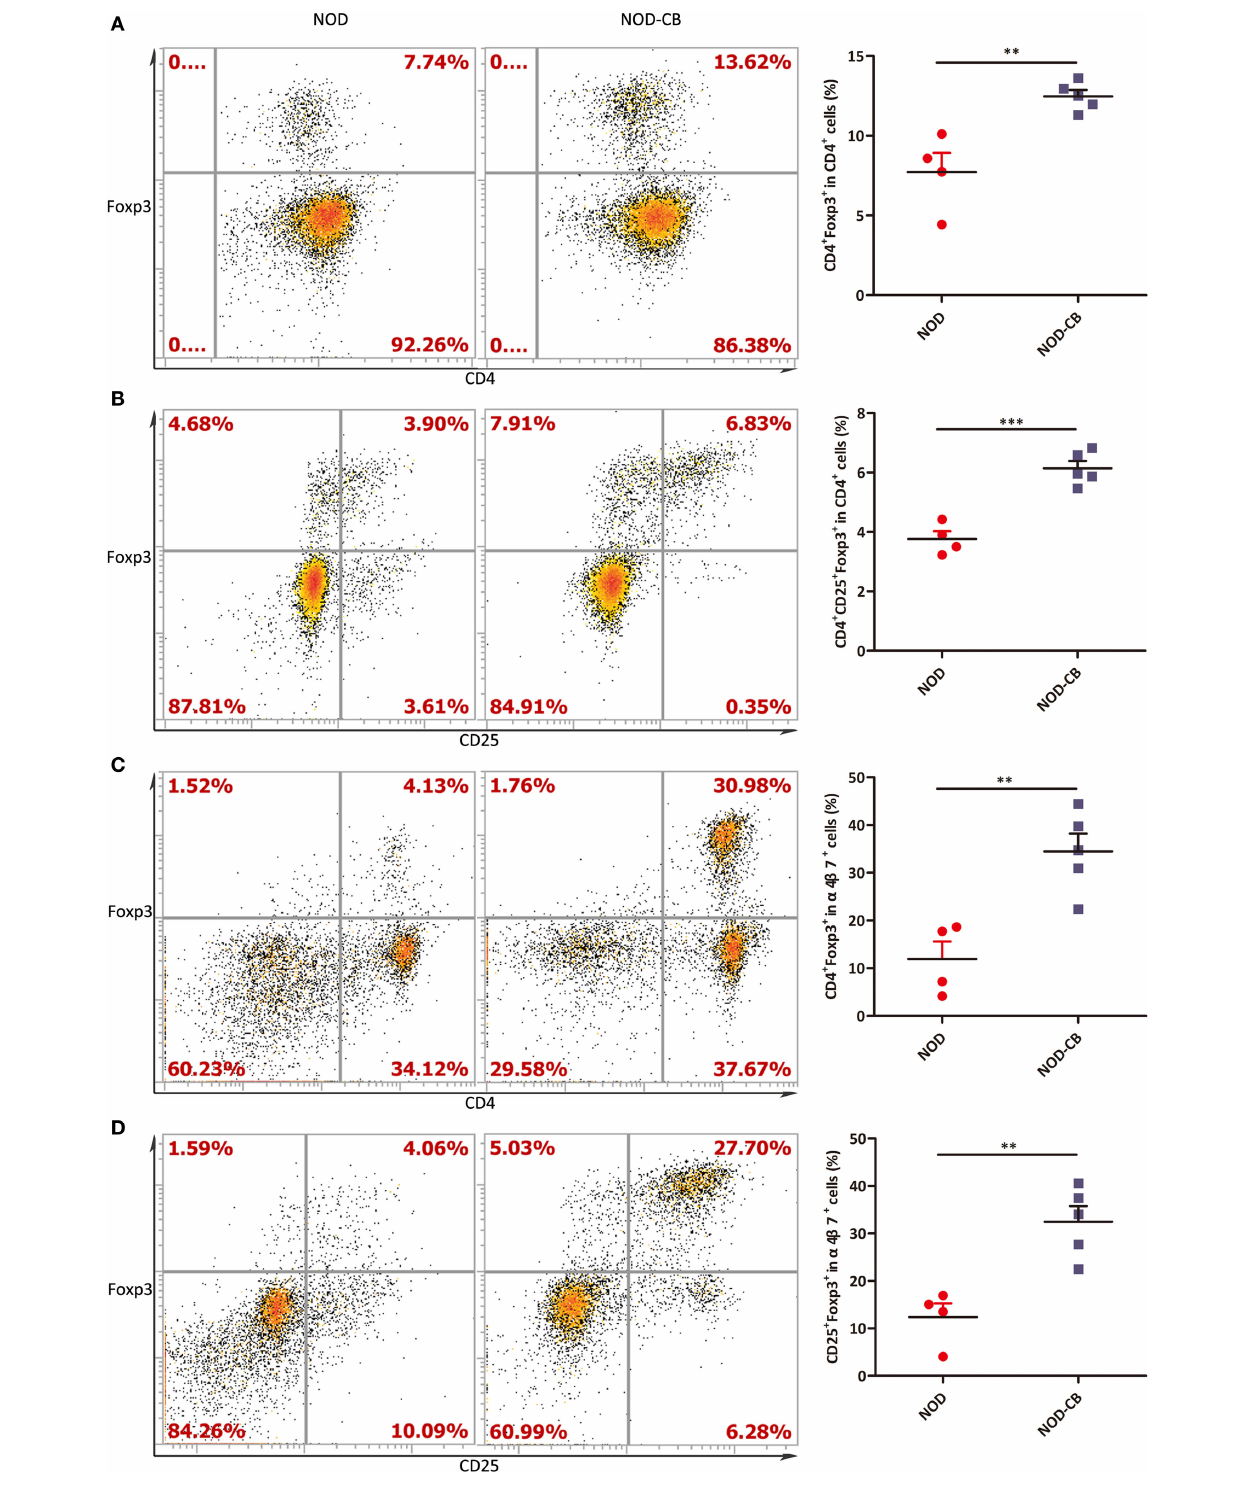
FigUre 6 | CB0313.1 promotes the migration of gut-primed Tregs to the PLN. (a) Percent CD4 + Foxp3 + cells in PLN. (B) Percent CD4 + CD25 + Foxp3 + cells in PLN. (c) Percent CD4 + Foxp3 + cells in α 4 β 7 + cells in PLN. (D) Percent CD25 + Foxp3 + cells in PLN. *** p < 0.05, p < 0.01, p < 0.001 vs NOD controls mice by t -test. The number of cells is